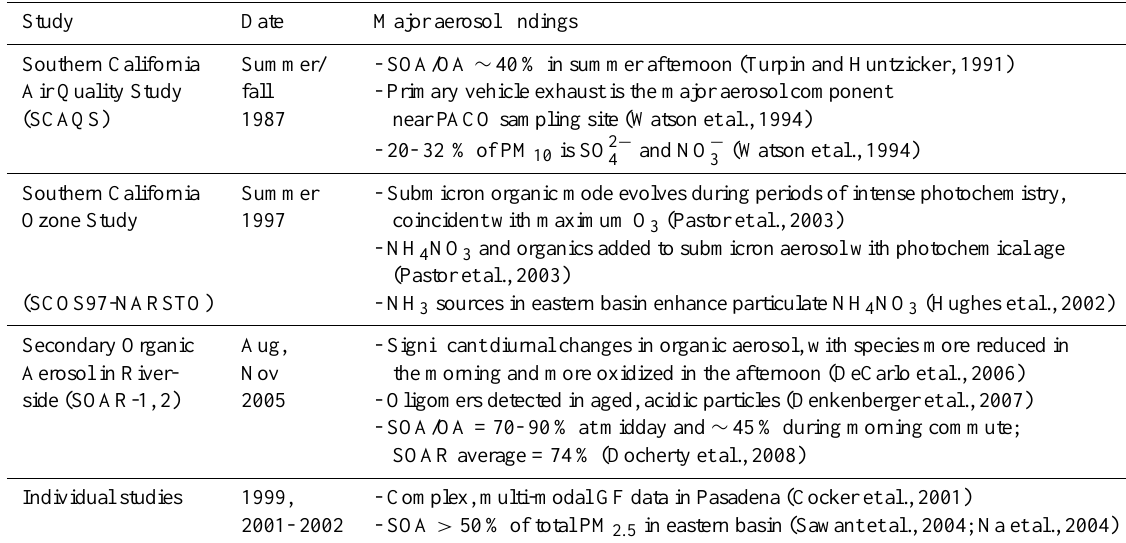
Table 1. Previous Los Angeles air quality studies and major findings relative to particulate